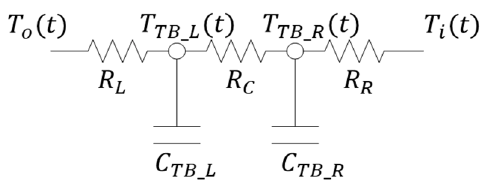
Figure A2. The 3R2C model.